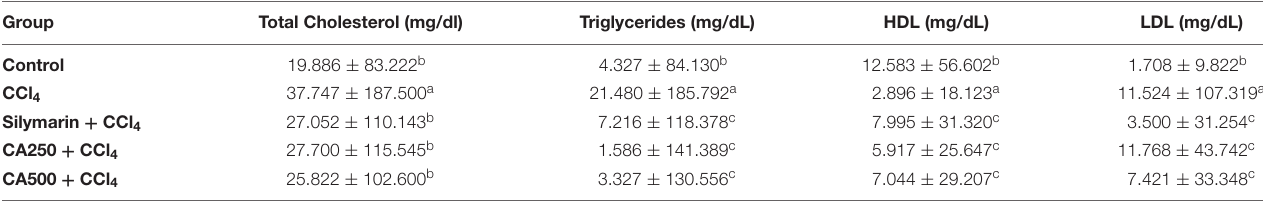
TABLE 2 | Hepatoprotective effect of reference drug silymarin, chickpea extract (CA250 and CA500) against CCl 4 induced hepatotoxicity on serum levels of total cholesterol, triglycerides, high density lipoprotein (HDL) and low density lipoprotein (LDL). Group